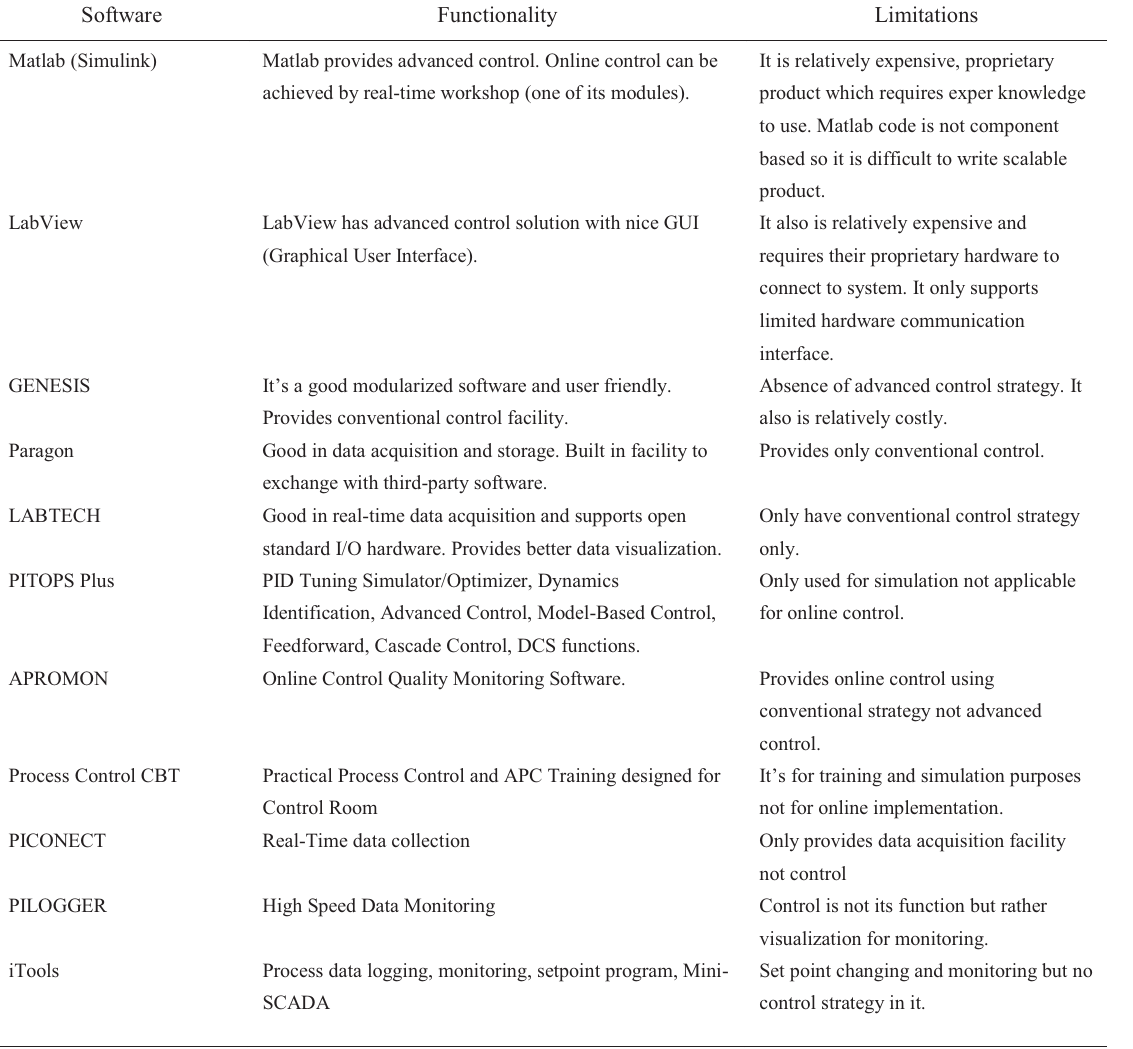
Table 1: Data acquisition and control software